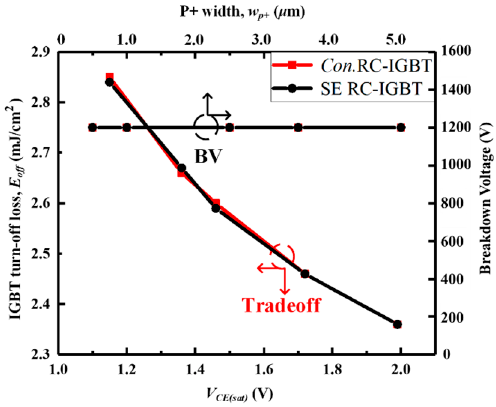
Figure 11. Breakdown voltage at different w p+ and trade-off relationship between E off and V CE ( sat ) of conventional RC-IGBT and SE RC-IGBT for different P-collector doping concentrations.